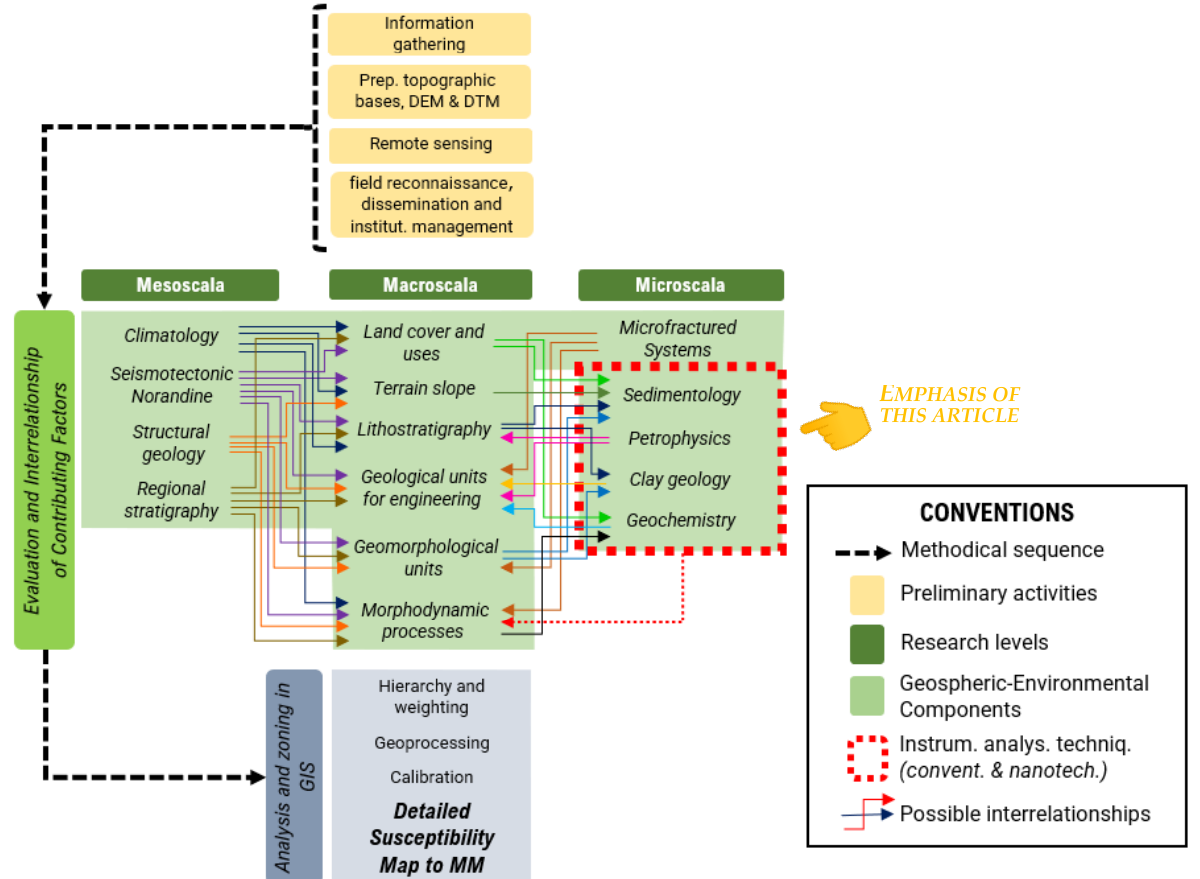
Figure 4. Methodological flowchart used in Reyes-Mendoza’s UB doctoral thesis (2019 version), with some of its products collected in this work. The phases, main activities, levels, thematic components, and analytical techniques (including microscale and nanosciences in the red dotted square on the right) are indicated in the central part. Contributing factors, from the subcontinental, national, regional levels to the local level, are inside the green rectangles; mapping scales (GIS analysis and zoning, below, in quadrangles of gray tones) range from a scale of 1:1.000.000, 1:100.000 to 1:2.000.